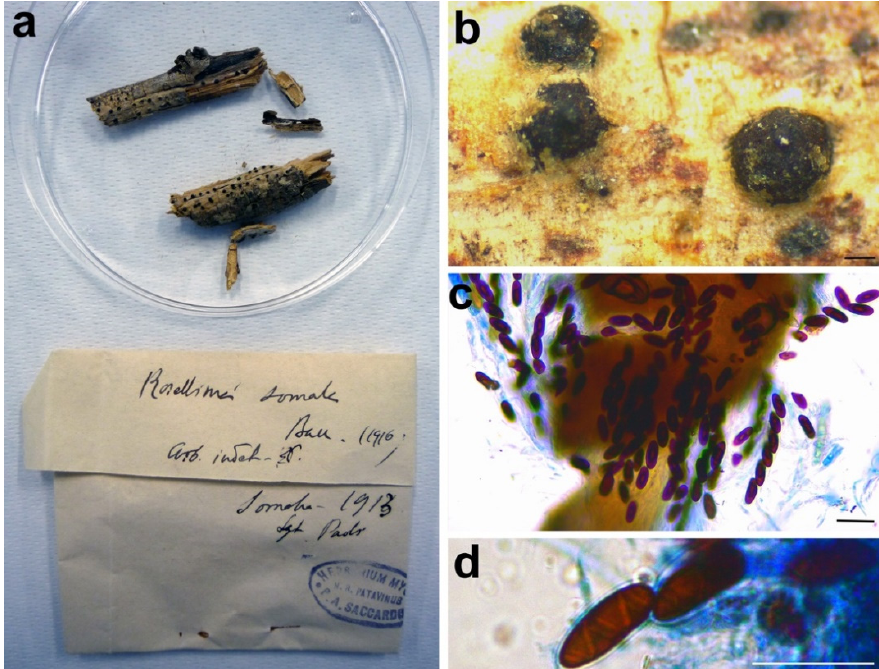
Figure 11. Rosellinia somala . ( a ) Original fungarium specimen. ( b ) Perithecia on natural substrate. ( c ) Ascospores. ( d ) Ascospore showing helicoid germ slit. Bars: ( b ) = 200 μ m; ( c , d ) = 20 μ m.